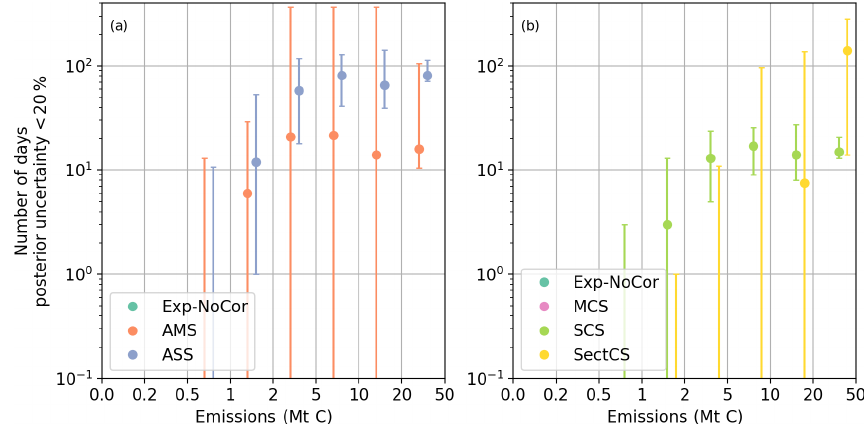
Figure 4. Number of days within the year when the posterior uncertainty of daily emissions is smaller than 20% (D20). The results are binned according to the clump annual emission with bin limits given on the x axis of the figure. Note that the median values of D20 for all clumps in Exp-NoCor and in MCS, for clumps whose annual emissions are between 0.5 and 1MtC in AMS, ASS and SCS, and for clumps whose emissions are below 10MtC in SectCS, are all zero, so that the dots in these cases are not visible on the y axis with log scale. The dots and error bars are the median and interquartile range of D10 for all clumps within the emission bin. Numbers at the figure top indicate the number of clumps and the percentage of clump emission within each bin.